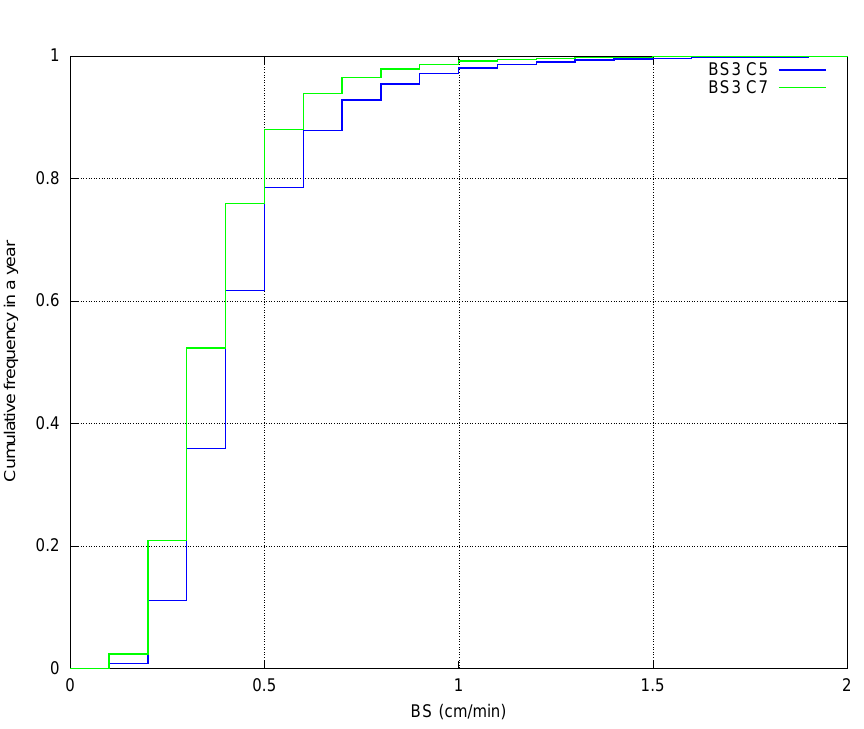
Fig. 9a. Normalised frequency distribution of BS3 for the configurations A3C5 and A3C7. Notice that most of the BS3 values are below 1cmmin − 1 .